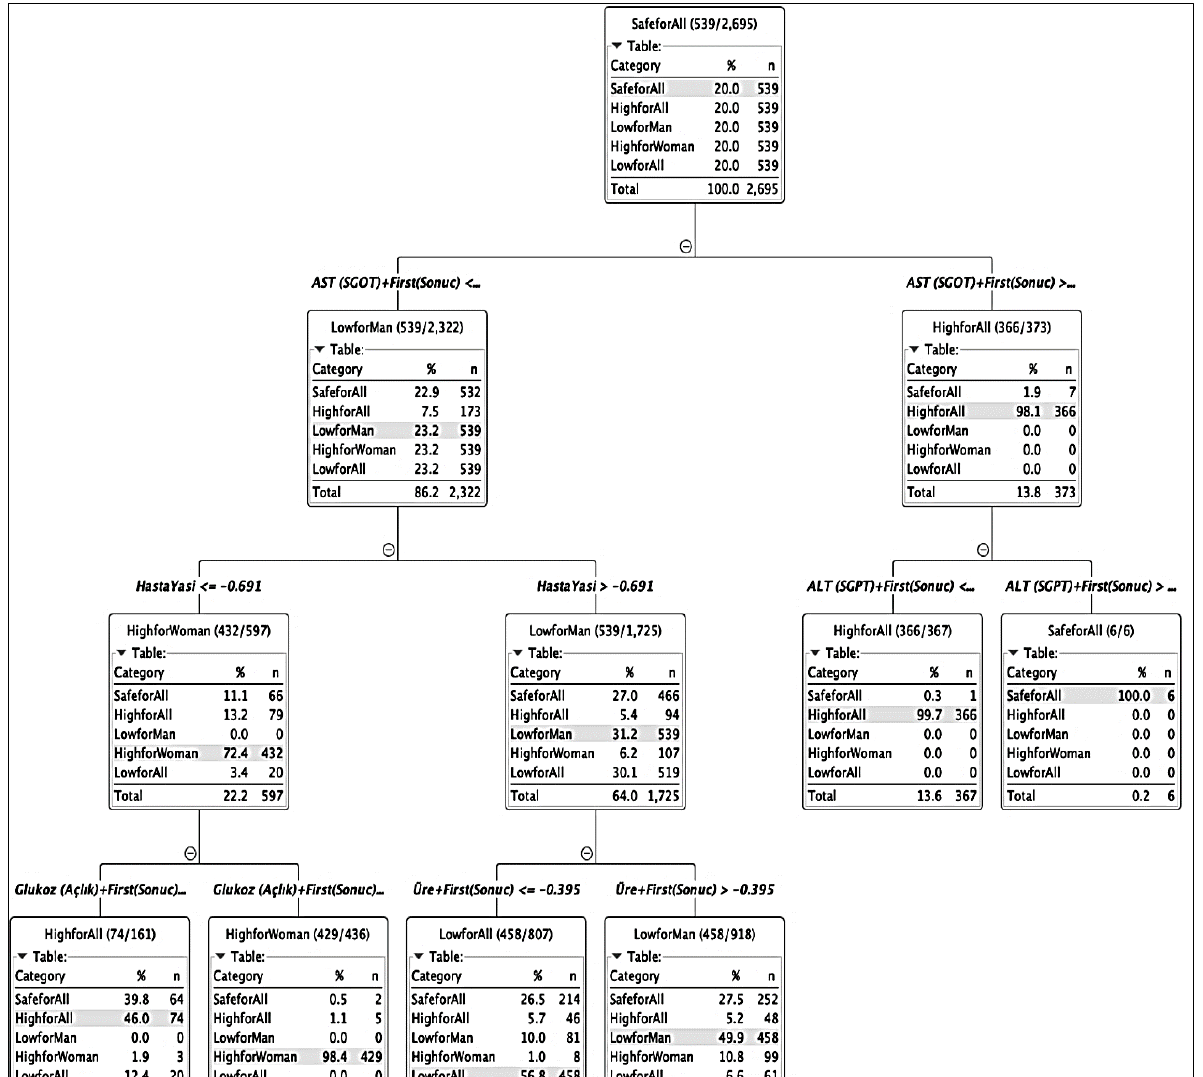
Figure 3. One of the decision tree generated by the random forest method (displays 2,695 records only).